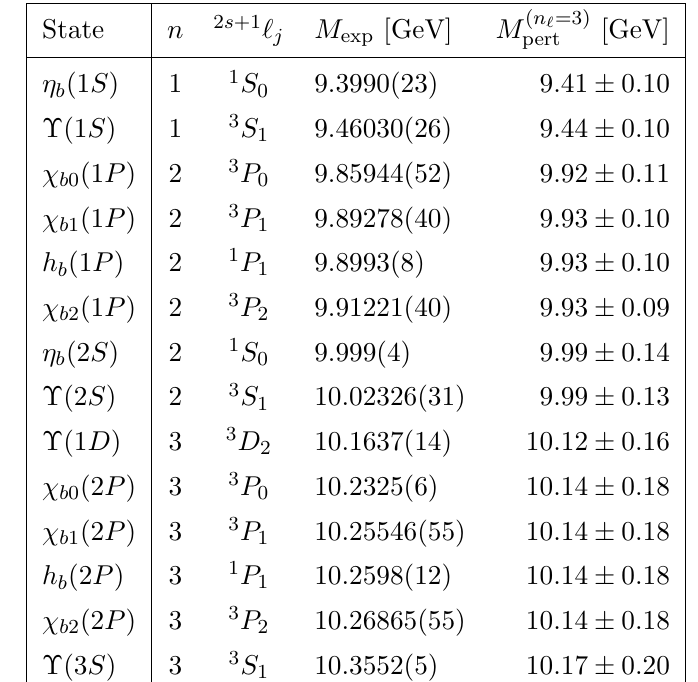
Table 3. Masses of the bottomonium states, up to n = 3, calculated with the perturbative formula of eq. (2.1) and with n ‘ = 3 dynamical (cid:13)avors. The results are computed with the (cid:12)nal bottom quark (cid:12)t value of m b = 4 : 216 GeV.